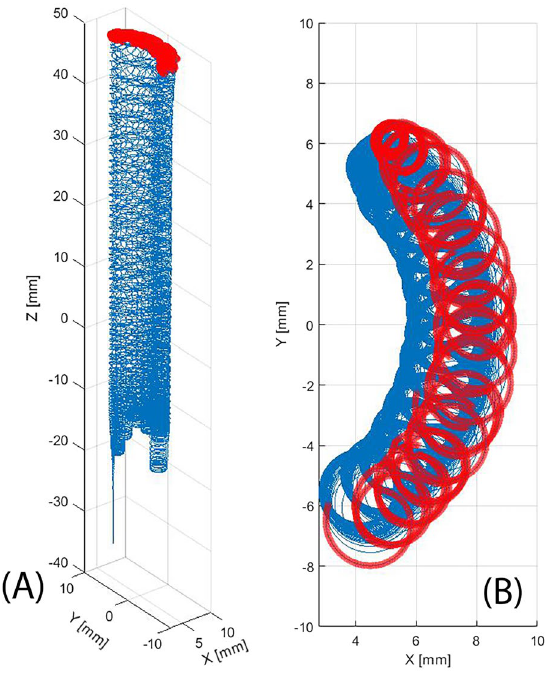
Figure 18. Three-dimensional view ( A ) and z-axis view ( B ) of one electron takes part of the cylindrical high- density region, trajectory closer to the extraction hole was marked with